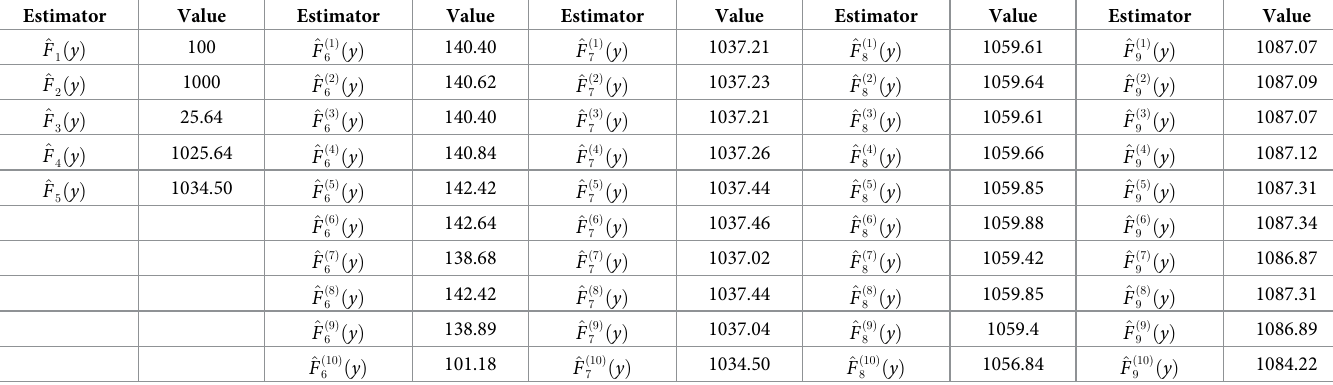
Table 5. PREs of distribution function estimators using Population III.